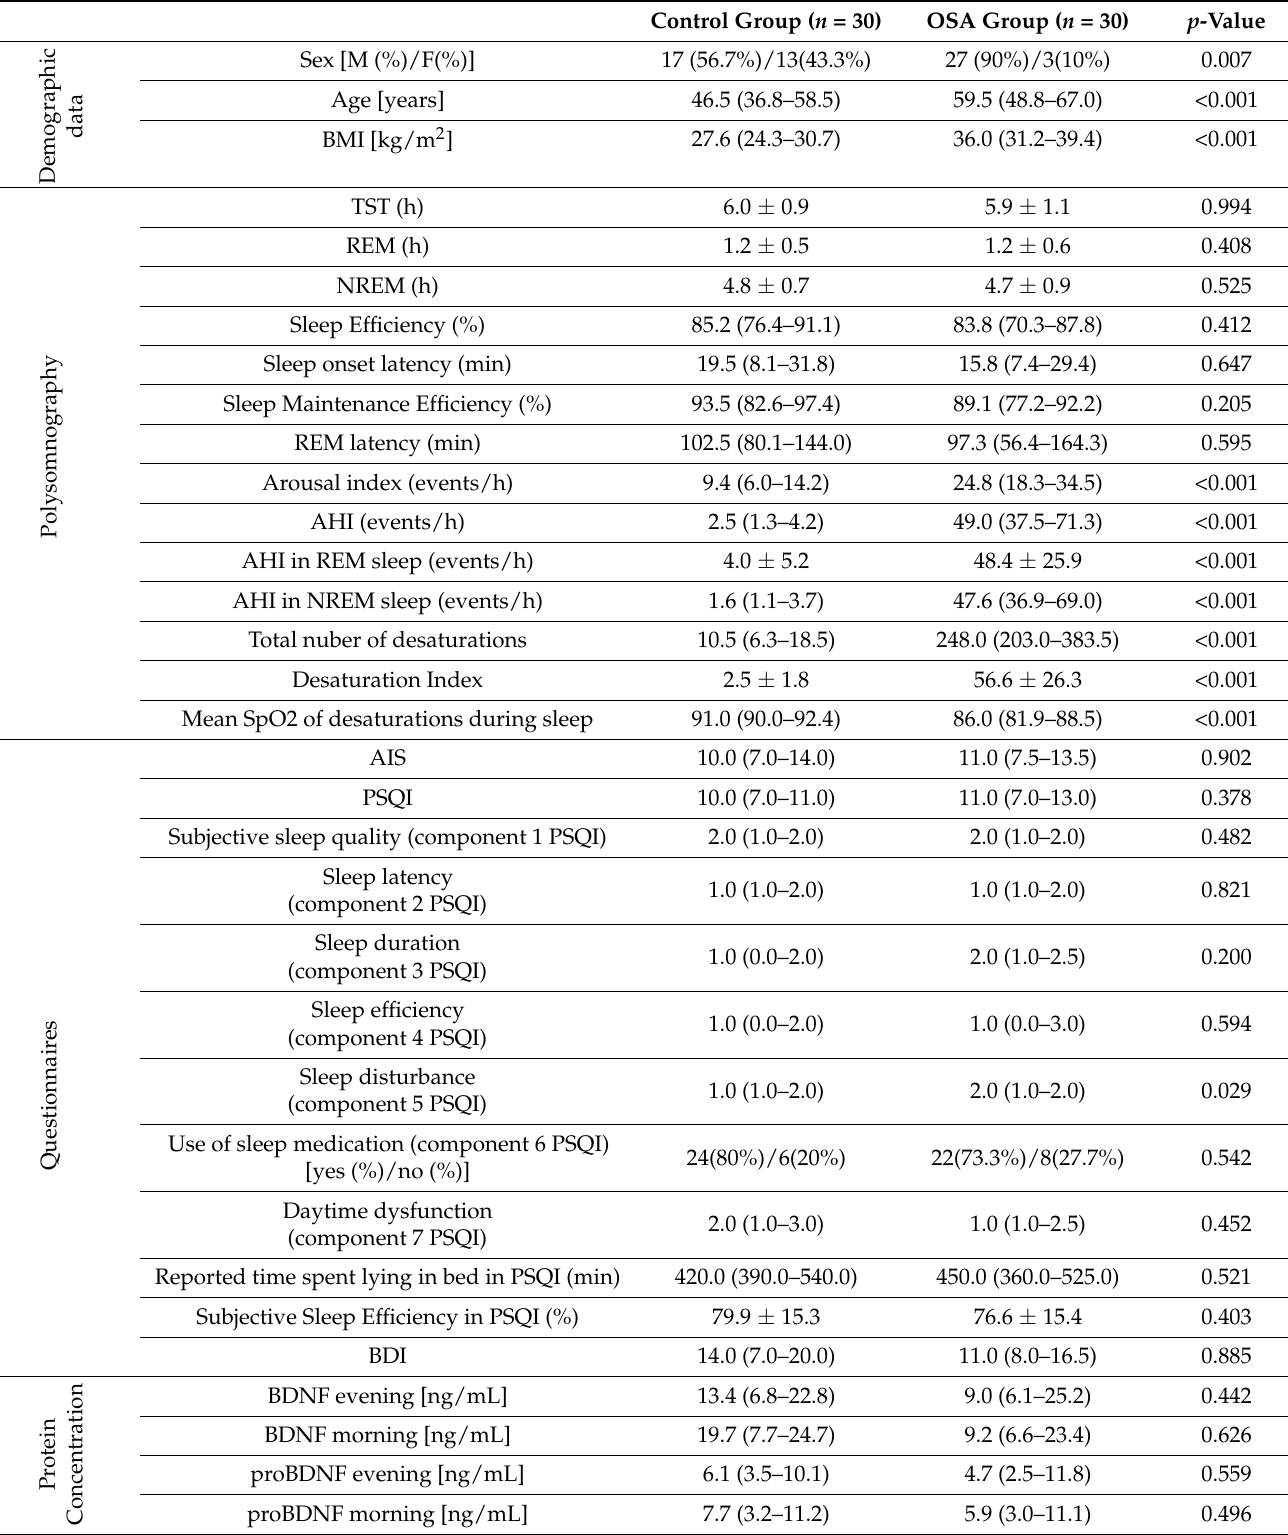
Table 1. Baseline characteristics of the study